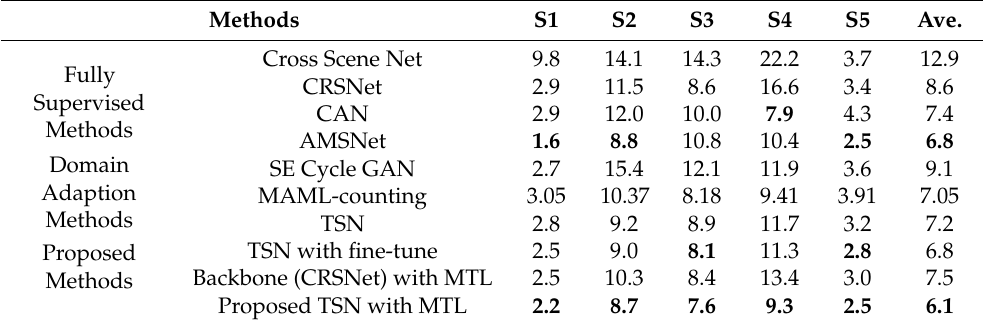
Table 1. The MAE comparison on WorldExpo’10. The best performance is colored red and second best is colored